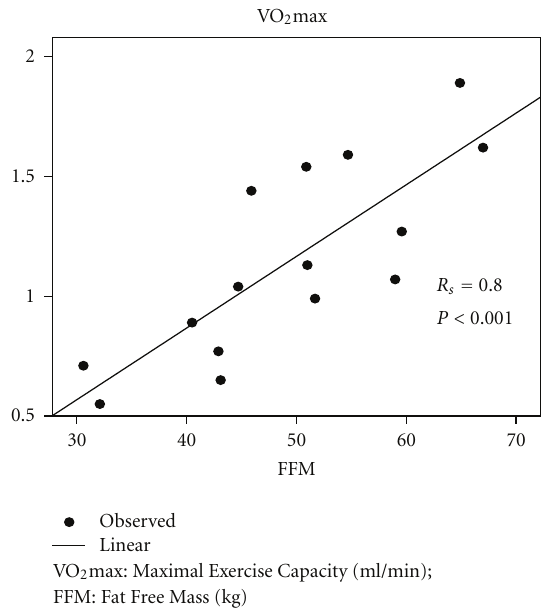
Figure 2: Correlation between maximal exercise capacity and muscle